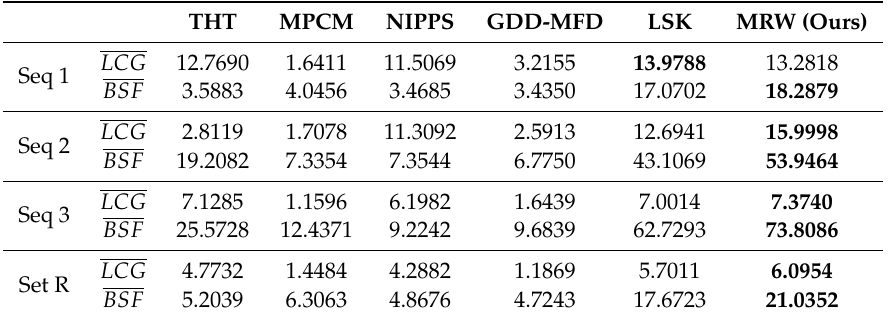
Table 3. Average LCG and BSF indicators of the output maps using different methods on the test dataset. THT